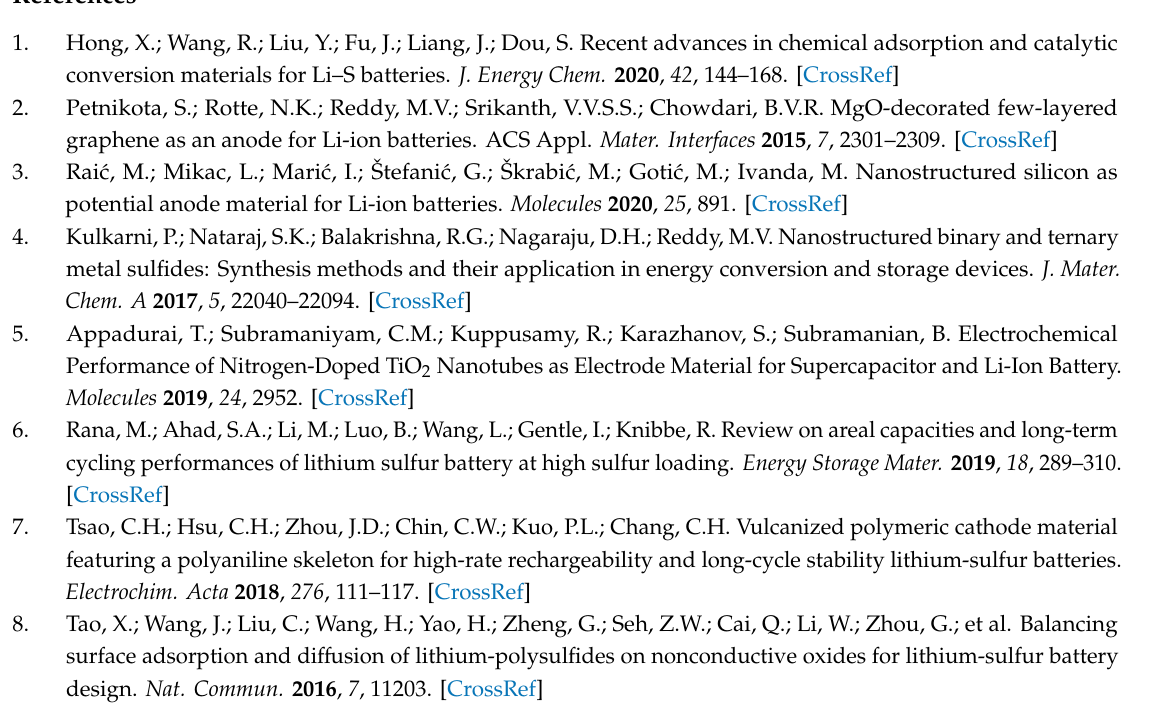
Supplementary Materials: The following are available online, Figure S1: TGA curves of MnO 2 / rGO and MnO 2 / rGO / CNTs, Table S1: Electrochemical properties of the reported MnO 2 -containing composite hosts for Li-S